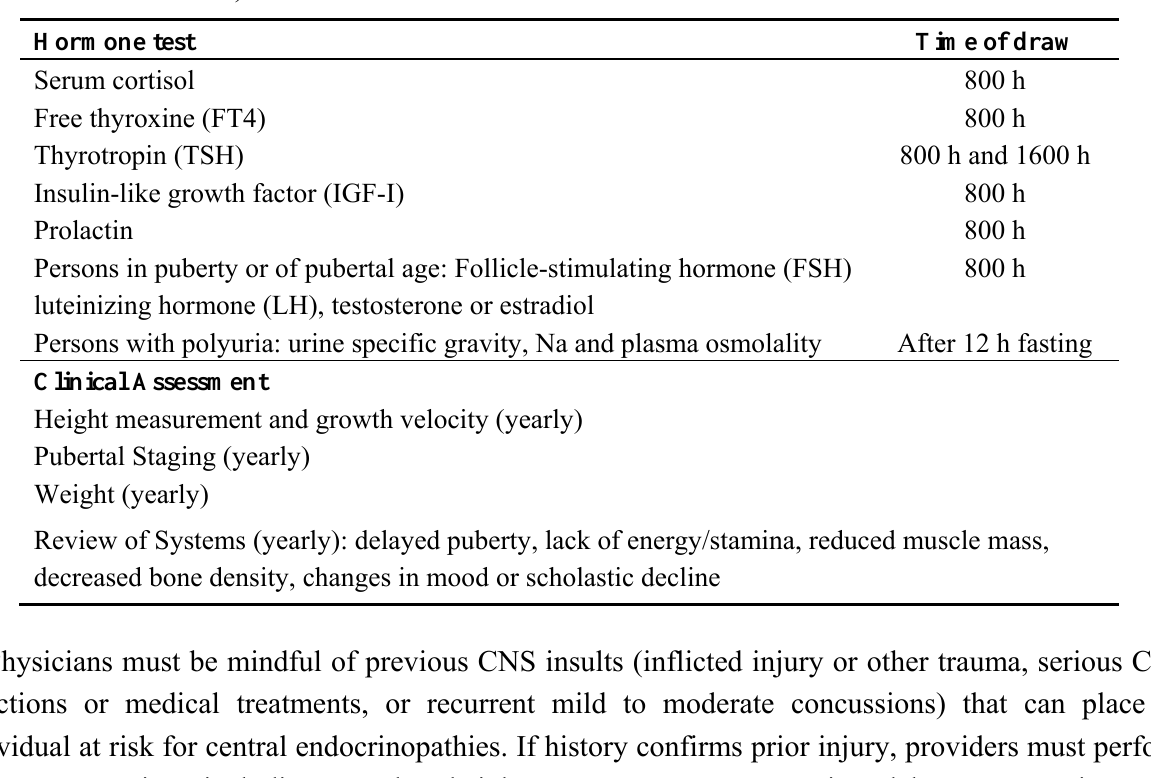
Table 2. Recommended screening tests for traumatic brain injuries (TBI)-induced hypopituitarism to be done acutely, 3 months, 6 months, and yearly after injury (modified from reference